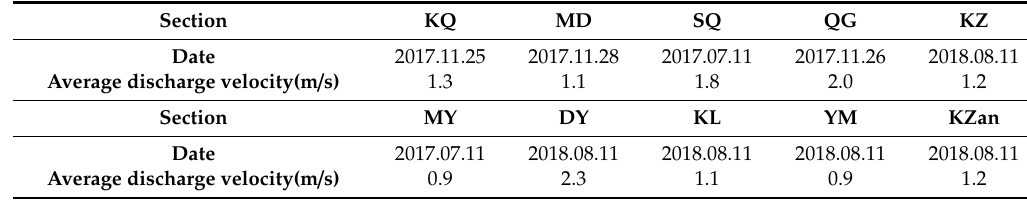
Table 2. Average discharge velocities and times of the sections.